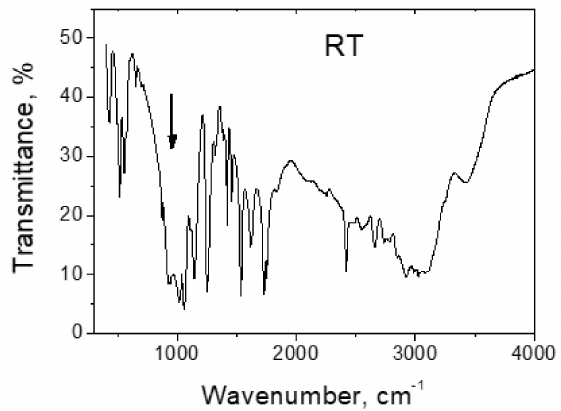
Figure 16. IR-spectrum of glycinium phosphite at room temperature. The arrow shows the expected position of the hydrogen bond absorption band. The Raman band in this region appears only at low temperatures (see Figure 17a).